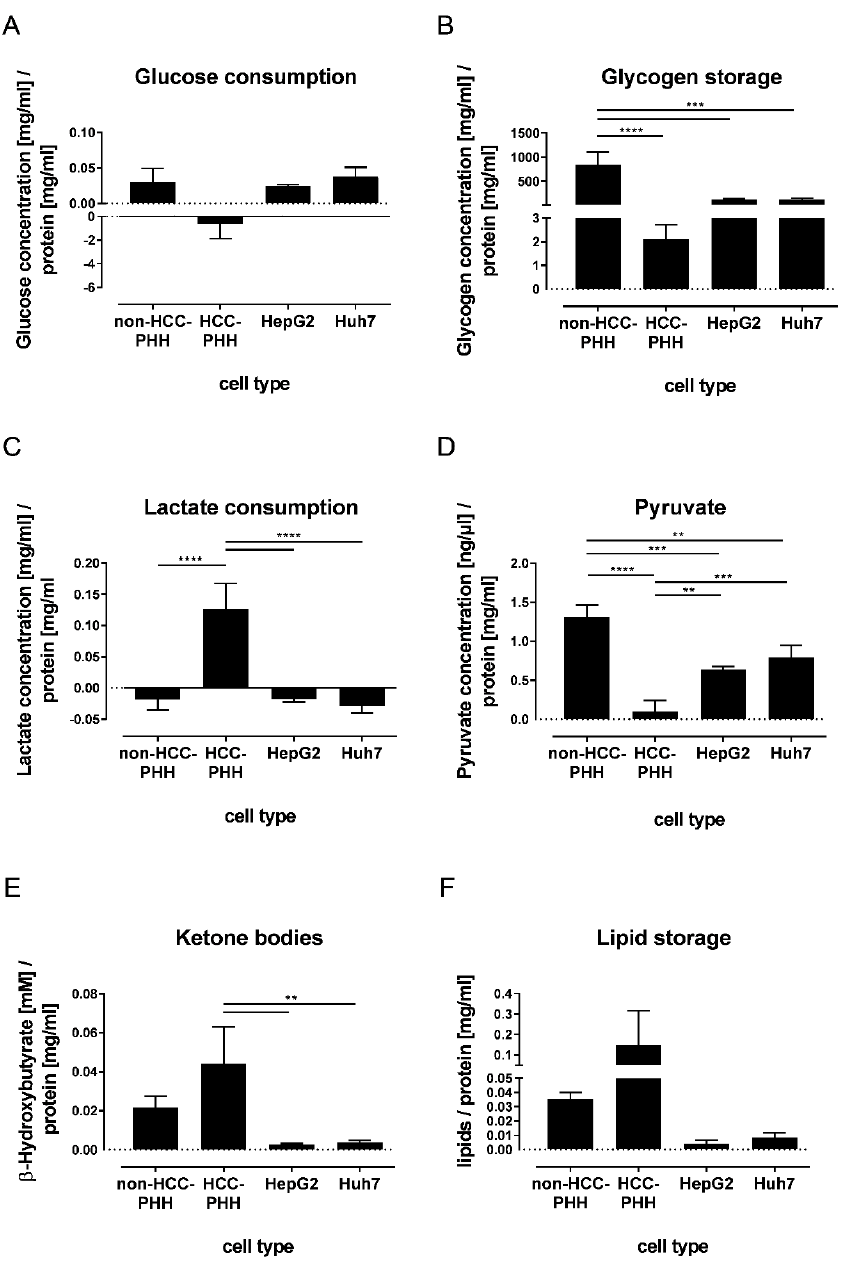
Figure 5. Dependence of cell functionality on cell type and differentiation state. Cells were cultured for 20 h and metabolic functionality was determined using functional assays. ( A – F ) Healthy hepato- cytes (non-HCC-PHH, N = 4) and PHHs from HCC-diagnosed patients (N = 4) were compared with hepatoma cell lines HepG2 and Huh7 (N = 3). Data are shown as means + SD and were normalized to protein content, n = 3, one- way ANOVA and post hoc Tukey’s test, ** p ≤ 0.0021, *** p ≤ 0.0002, **** p < 0.0001. Abbreviations: PHH, primary human hepatocyte; PHC, primary human hepatoma cell; HCC, hepatocellular carcinoma.